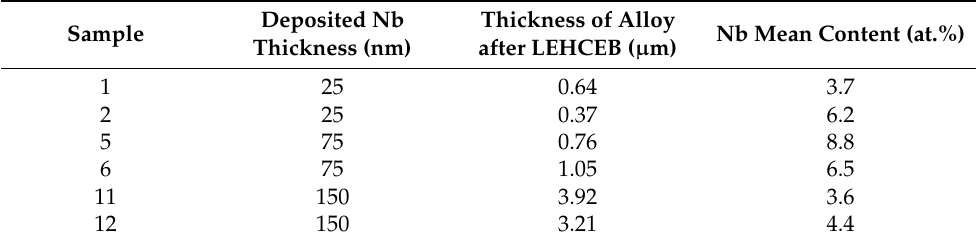
Table 8. Nb mean content calculated from GDOES data of set